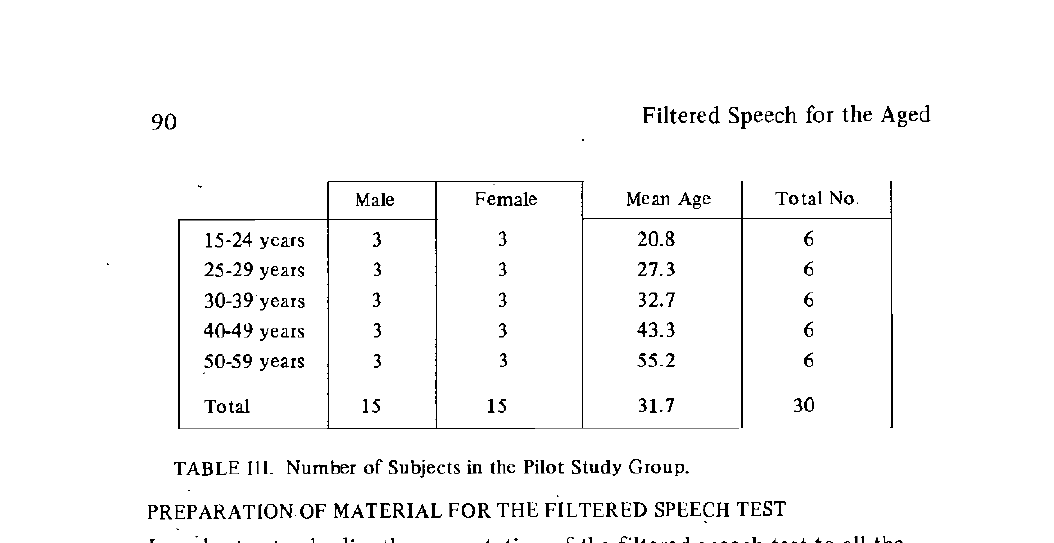
TABLE 111. Number of Subjects in the Pilot Study